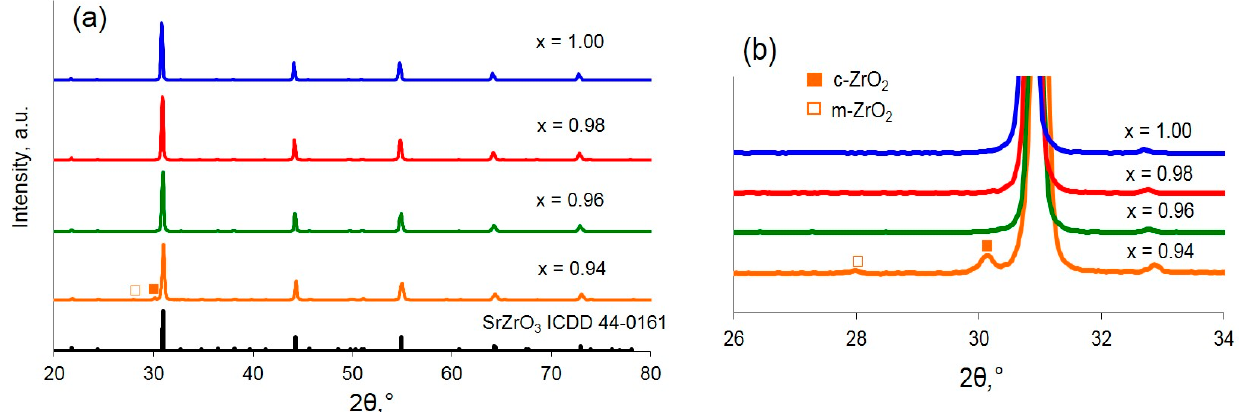
Figure 1. XRD patterns of the samples Sr x Zr 0.95 Yb 0.05 O 3- δ : ( a ) in the range of 20–80°, ( b ) enlarged XRD pattern between 26° and 34°.